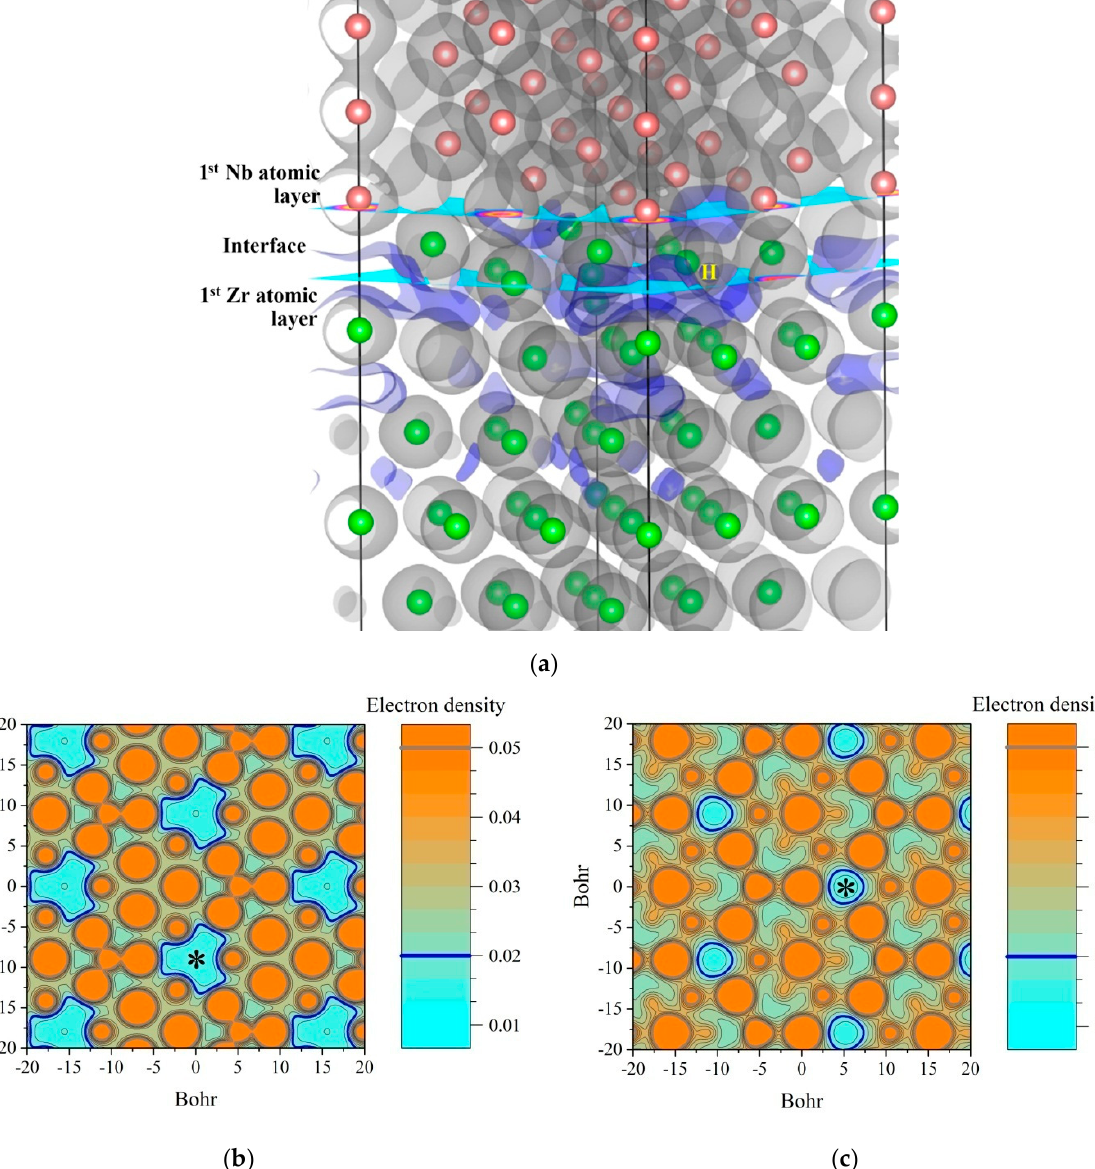
Figure 12. Electron density distribution in the interface vicinity of Zr 63 Nb 40 H slab with H atom in tetrahedral (T6) site ( a ) and in the first Zr ( b ) and Nb ( c ) atomic layers. The blue and gray isosurfaces in panel ( a ) correspond to a charge density of 0.02 and 0.05 electrons/Bohr 3 , respectively. The areas of a reduced electron density in the Zr ( b ) and Nb ( c ) atomic layers are marked with (*). Color gradation scale in the ( b , c ) panels is given in electrons/Bohr 3 units.